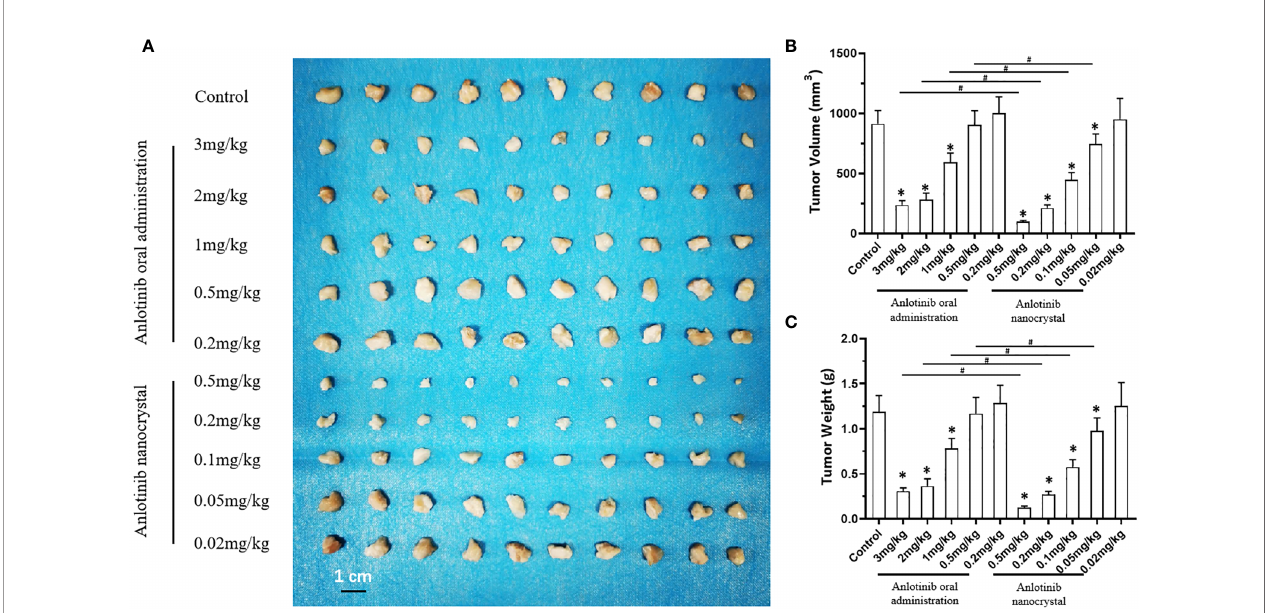
FIGURE 4 | Effect of anlotinib formulation (anlotinib crude suspension or anlotinib nanocrystal preparation) on subcutaneous tumor formation by MHCC97-H cells. MHCC97-H cells were subcutaneously injected into nude mice to generate tumoral tissues. The mice received an oral anlotinib crude suspension or the intravenous anlotinib preparation via the tail vein. The results are shown as tumor tissue images (A) , tumor volumes (B) , or the tumor weights (C) . *P < 0.05 versus anlotinib with control; # P < 0.05; n = 10 for every group.